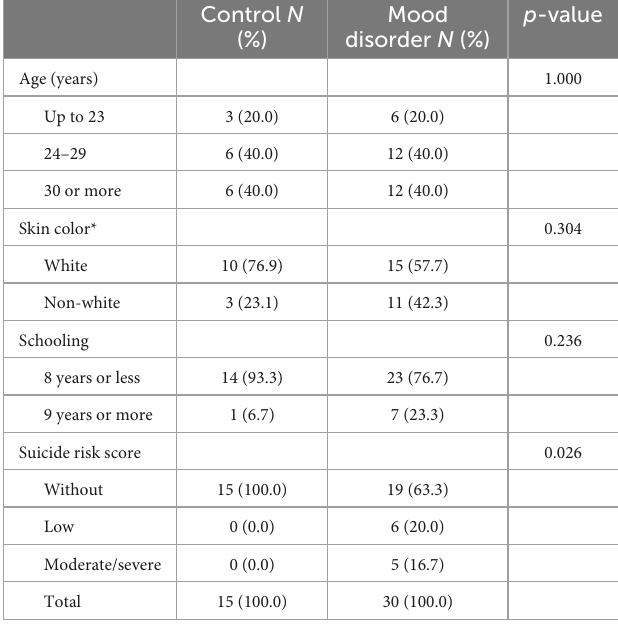
TABLE 1 Sample characteristics of women (control or mood disorder) at risk of